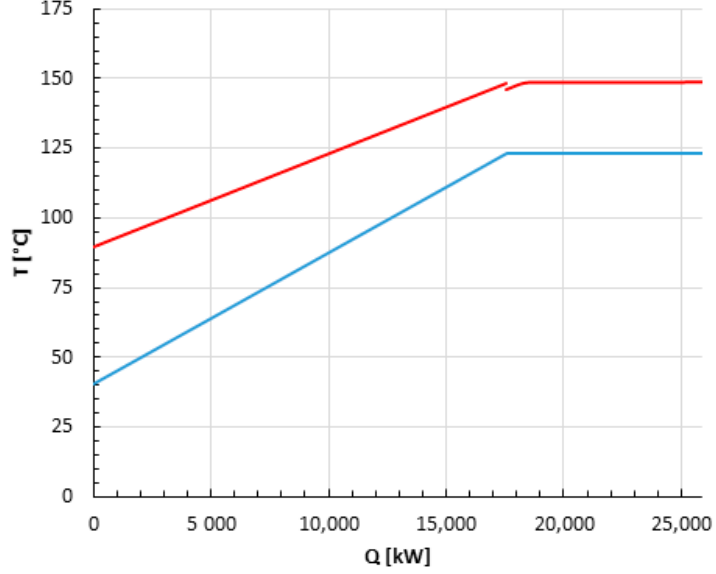
Figure 6. Temperature–enthalpy diagram of the waste heat recovery for the case study 1a, Bagnore).